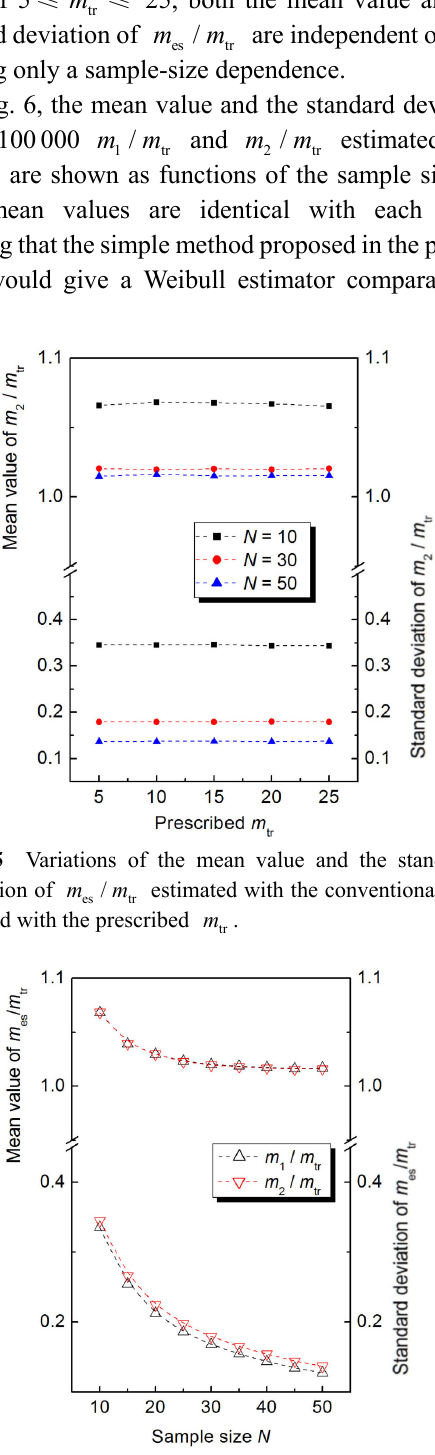
Fig. 4 Variations of the best-fit values of the parameters  and  with sample size.